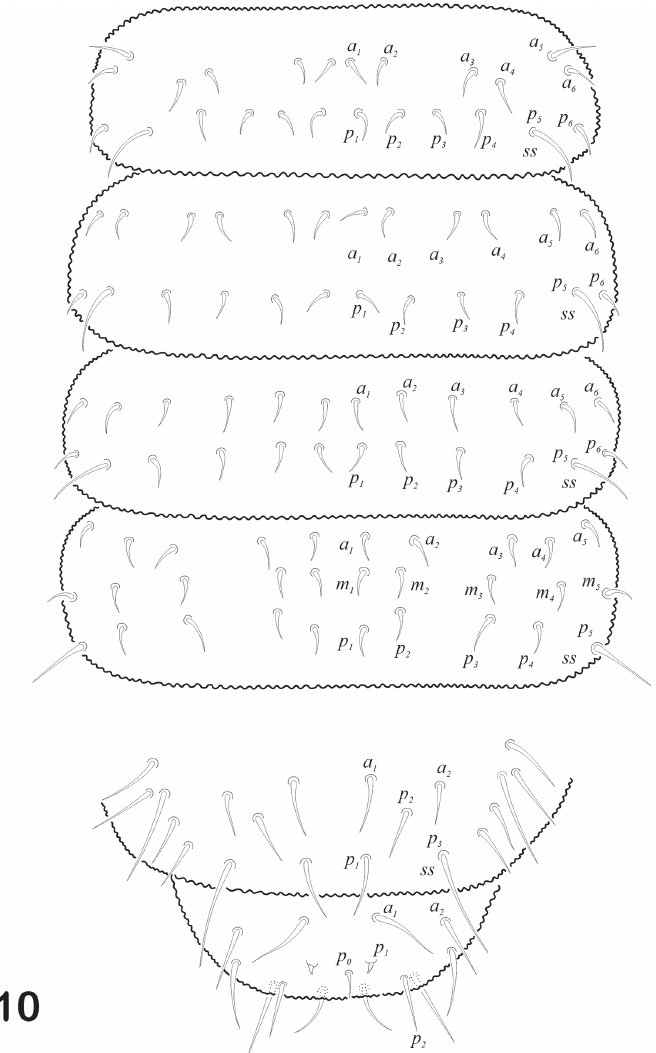
Figure 10. Acheroxenylla lipsae sp. nov. Dorsal abdominal